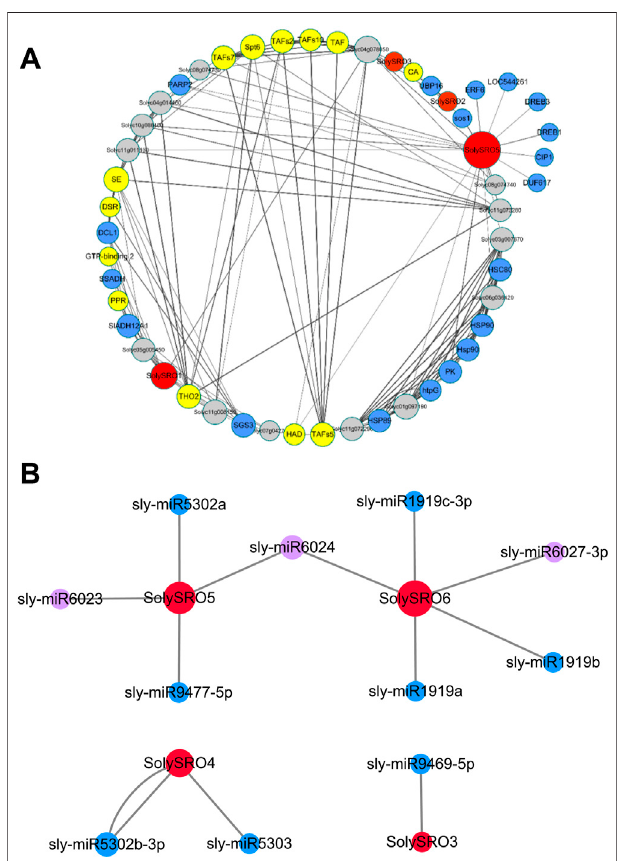
FIGURE 5 | Inter-crossing network diagram of SRO genes in tomatoes. (A) Interaction network of the SRO family with other proteins. Each node is a protein, each edge represents the presence of interactions, the size of the node represents the number of interactions, the thickness of the edge represents the value of the combined score, red nodes represent SRO proteins, blue nodes represent stress-related proteins, yellow nodes are transcription factors, and grey nodes represent proteins lacking annotation. (B) SRO genes and micoRNA targeting interactions. The red nodes are SRO genes, the size of the node represents the number of interactions, the blue nodes represent abiotic stress-related microRNAs, and the purple nodes are biotic stress-related